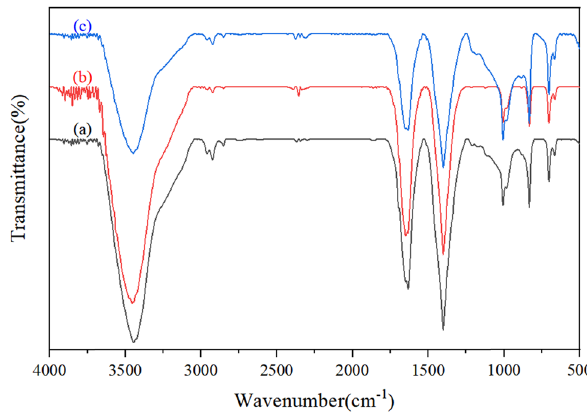
Figure 8: FTIR spectra of ( a ) U - BF, ( b ) C - BF, and ( c ) K1.0 -